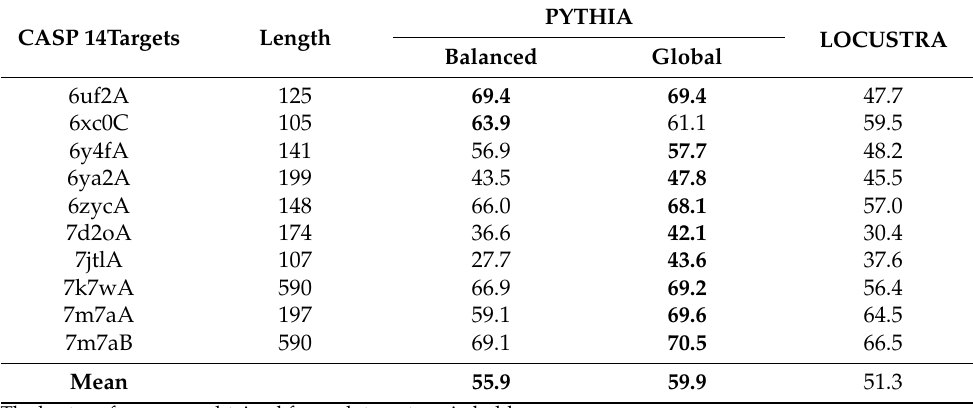
Table 3. Q 16 on the CASP14 free modelling targets (%) for two PYTHIA models (the balanced and global accuracy) and LOCUSTRA reference PB prediction method. CASP 14Targets Length